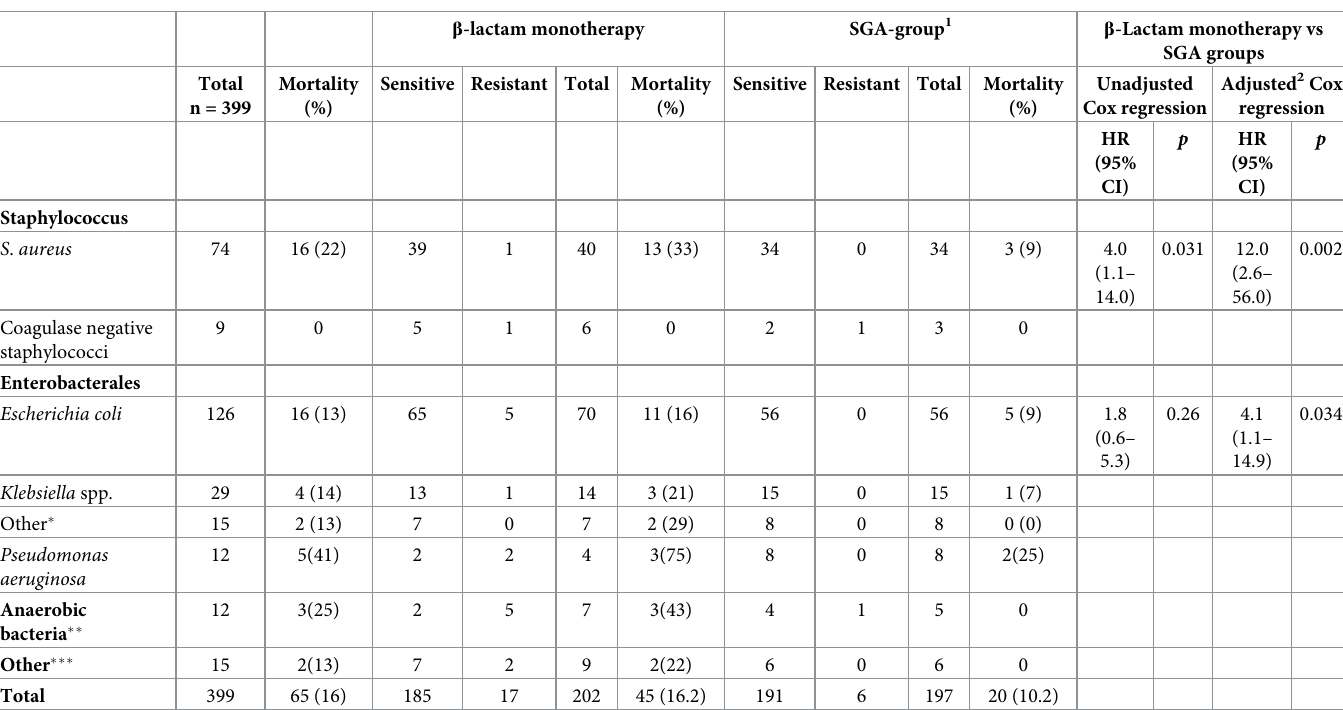
Adjusted for age, Charlson comorbidity score, SOFA-score and NEWS2-score as continuous variables and sex, broad- or narrow antibiotic spectrum